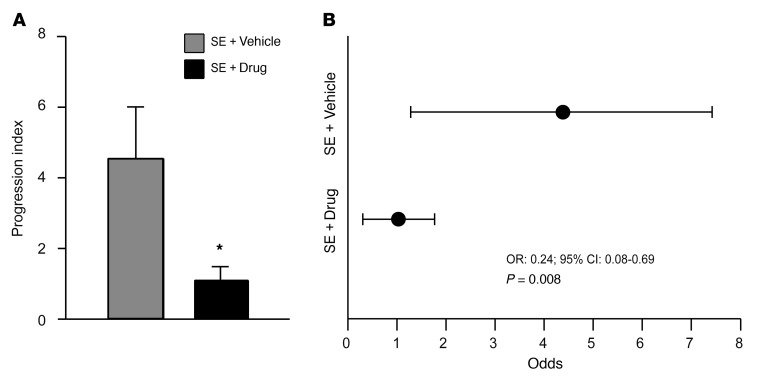
Antiinflammatory drugs administered during epileptogenesis prevent disease progression in electrical SE–exposed rats.(A) Progression index (the ratio between the number of seizures at 4.5 months and at 2.5 months after SE) in vehicle- and drug-treated rats. Value equivalent to 1 defines lack of progression. Data are shown as mean ± SEM (n = 9 rats each group). *P < 0.05 versus vehicle, Mann-Whitney U test. Raw data are shown in Supplemental Table 1. (B) Odds ratio (0.24; P = 0.008) indicates that drug-treated rats evaluated at 2.5 months have a 76% reduced risk of developing seizures at 4.5 months versus vehicle-treated rats. Treatment included anakinra+BoxA+ifenprodil (SE+drug) (see Methods; Supplemental Figure 5A). OR, odds ratio.